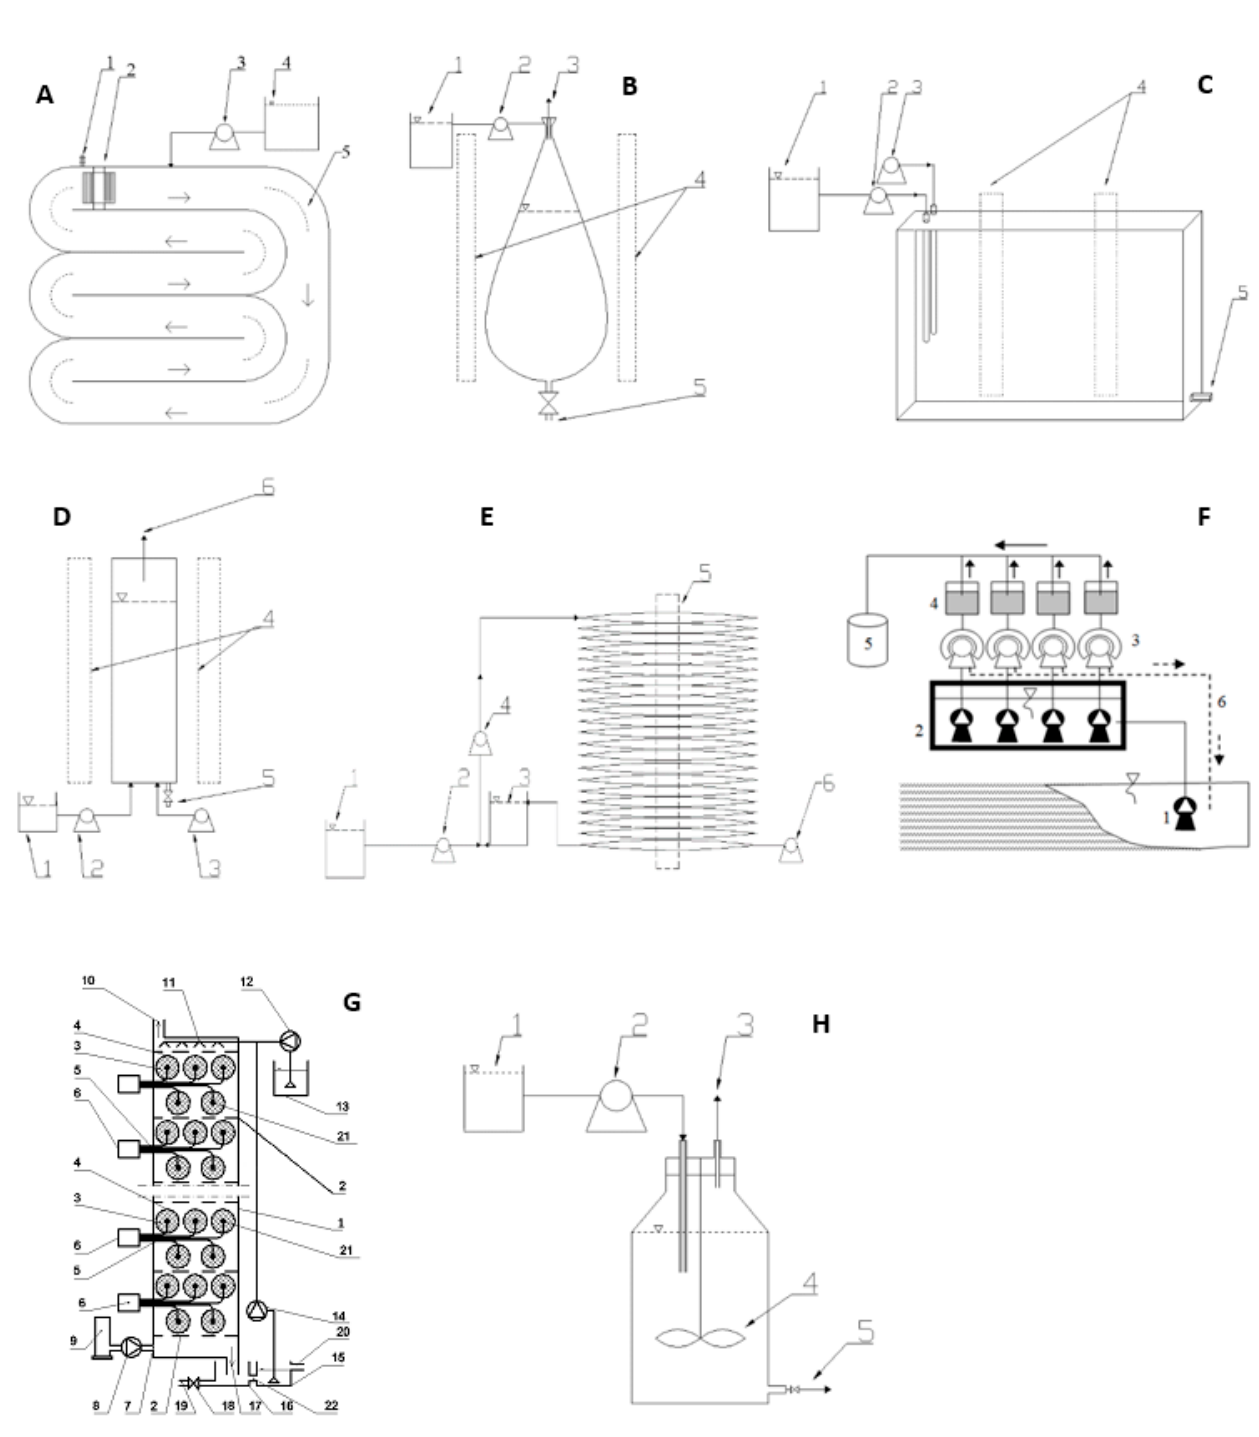
Figure 8. Systems for production and extraction of microalgal biomass. ( A ) Raceway pond reactor